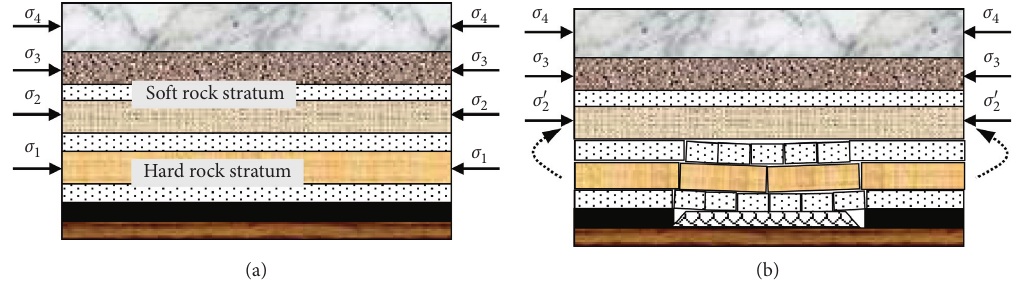
Figure 8: Horizontal stress distribution and transfer model in the vertical direction. (a) Distribution of the initial horizontal stress. (b) Upward transference of the horizontal